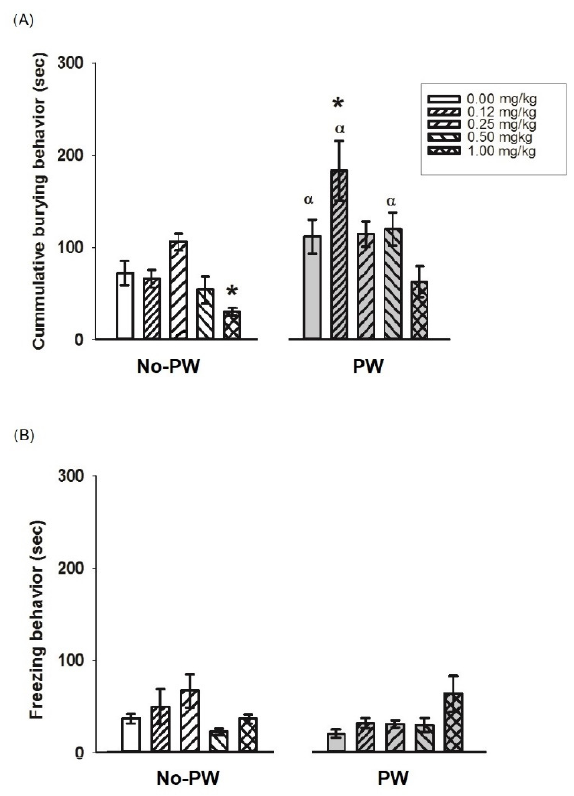
Figure 5. Effect of different doses of diazepam in Wistar Kyoto rats subjected to PW on cumulative burying behavior ( A ), and freezing behavior ( B ), registered in the burying behavior test (n = 5–7 per group). Data are presented as the mean ± standard error of the mean. * p < 0.05 vs. diazepam 0.00 mg/kg; α p < 0.05 vs. No-PW diazepam (different doses).